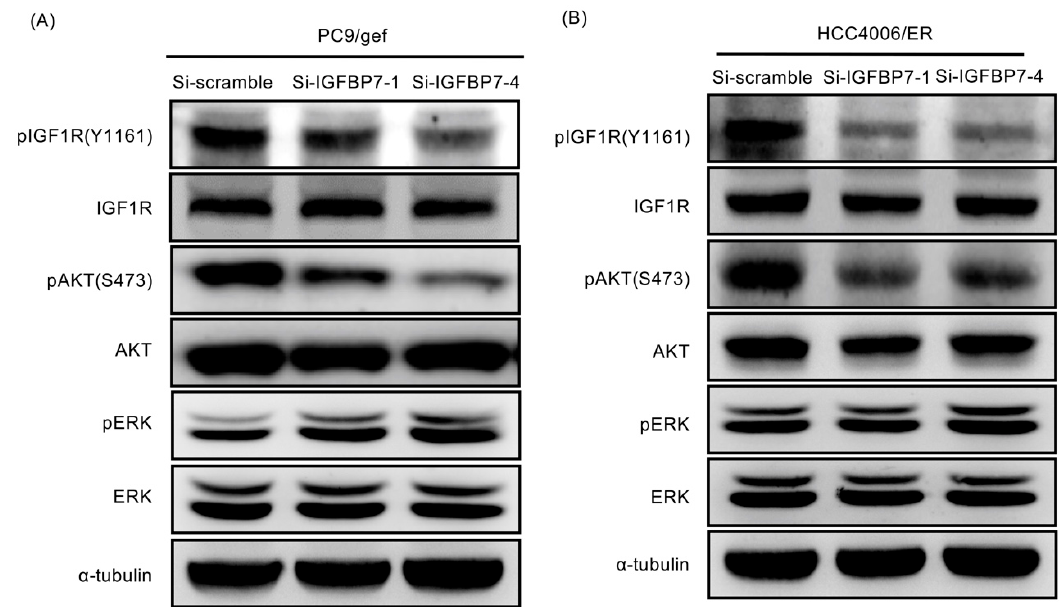
Figure 5. Suppression of IGFBP7 reduced phosphorylation of IGF-1R and downstream AKT ( A ) PC9/gef and ( B ) HCC4006/ER were transfected with si-IGFBP7-1, si-IGFBP7-4, or scramble siRNA (si-scramble) for 48 h. Western blotting showed that IGFBP7 -knockdown cell lines decreased the phosphorylation of IGF-1R and AKT, except for ERK phosphorylation.